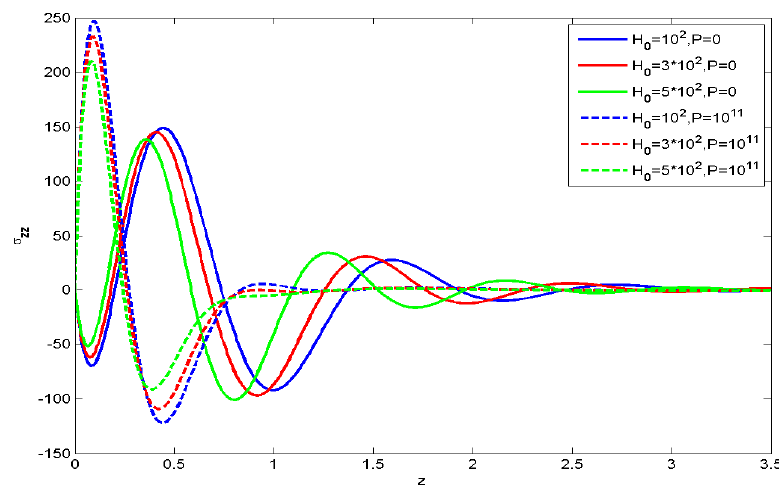
Figure 20. Normal stress σ xx concerning z with magnetic field H 0 .